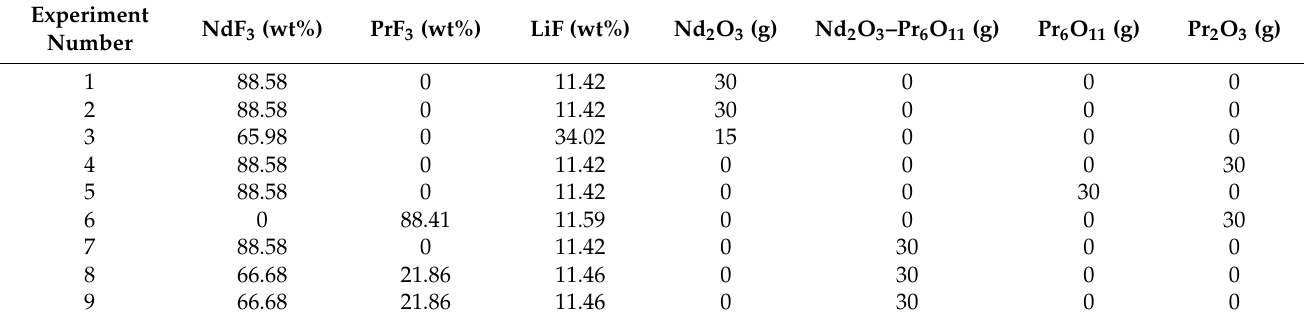
Table 3. Composition of 1 kg fluoride electrolyte and the total amount of REO added in each experiment.